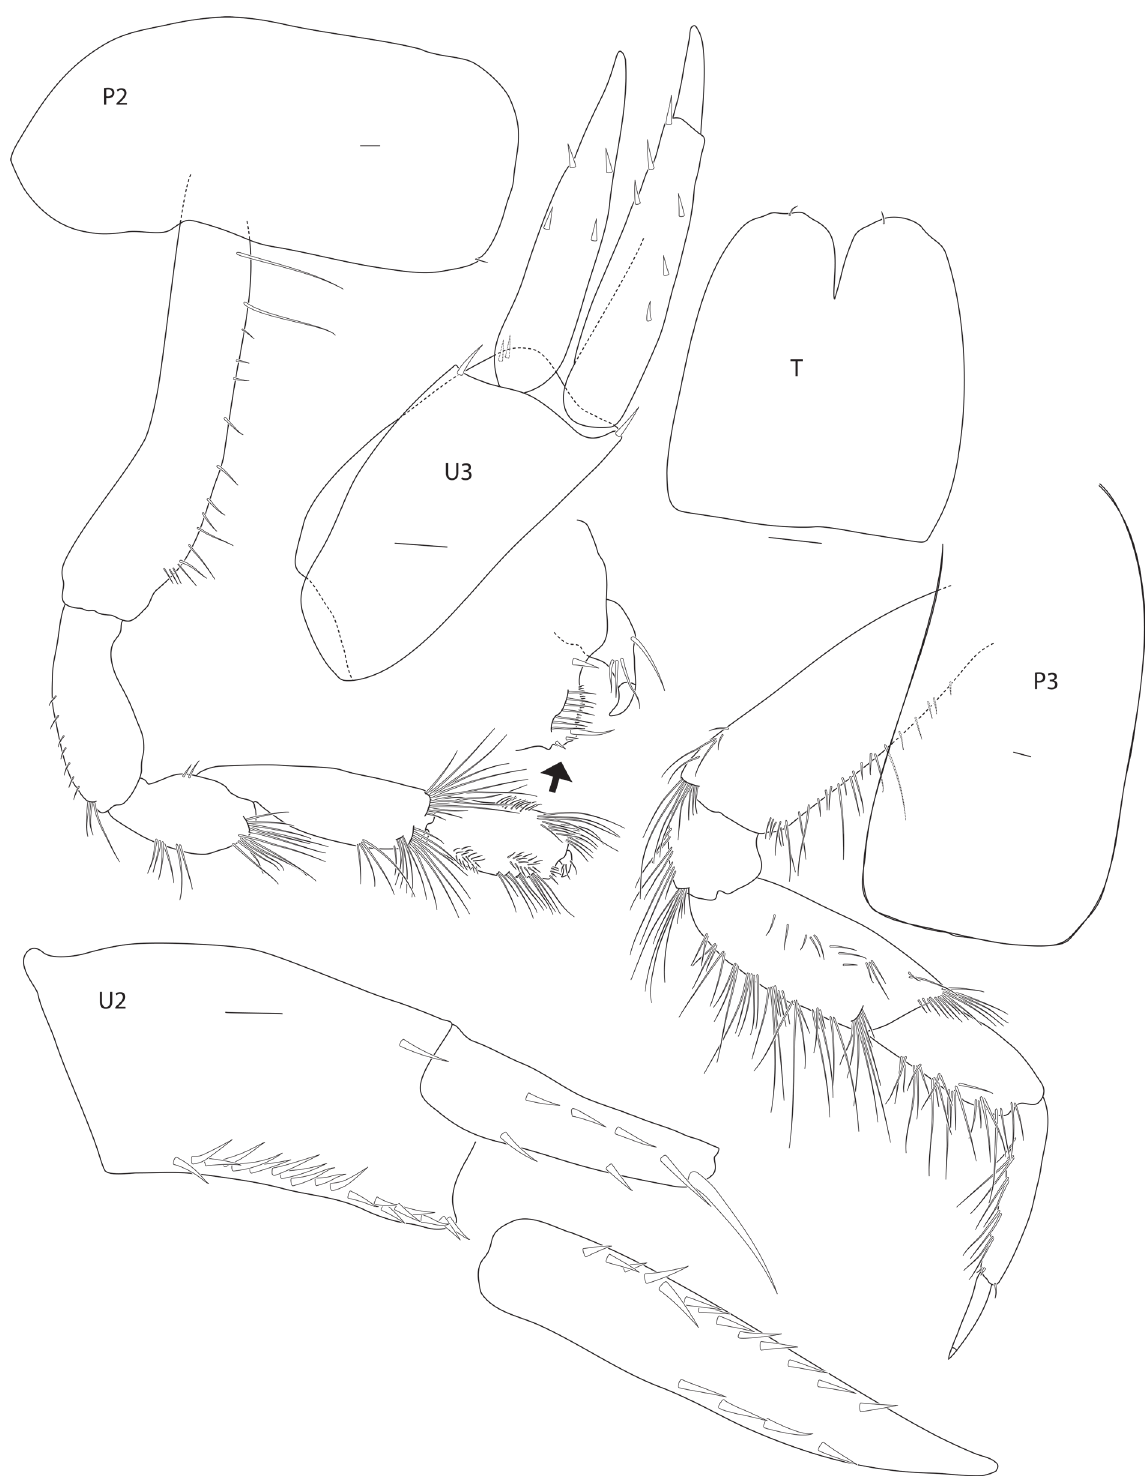
Fig. 5. Onisimus turgidus (Sars, 1879), syntype, ♀, 15 mm, Barents Sea (F1764). Pereopods 2–3, uropods 2–3, telson. Abbreviations: see Material and methods. Scale bars = 0.1